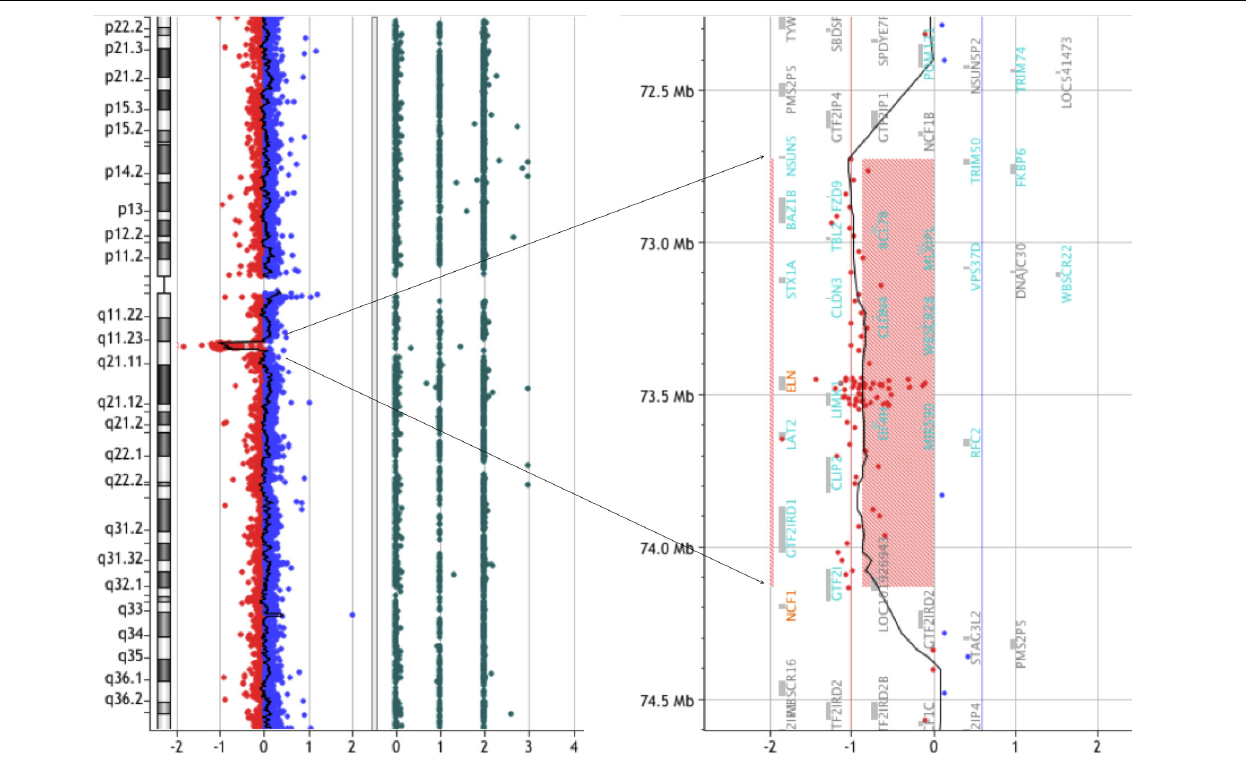
FIGURE 1 | CGH array analysis of the microdeletion in chromosome seven of a WBS patient. CGH array profile of chromosome seven revealing the heterozygous deletion in 7q11.23.